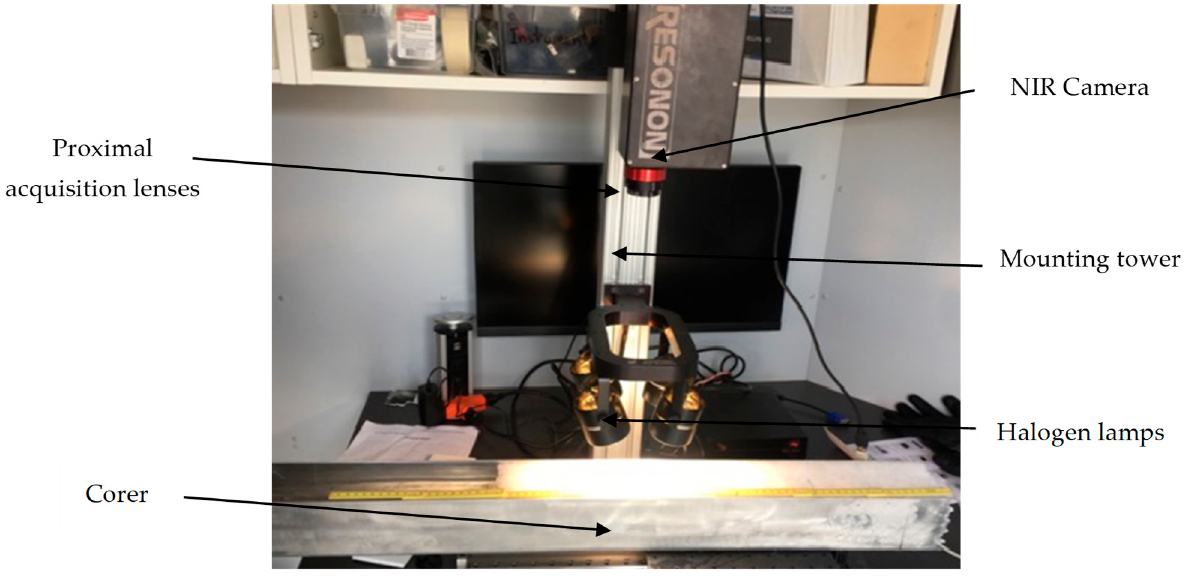
Figure 3. NIR spectral reflectance acquisition device for the vertical profile of snow samples from the company RESONON (Resonon Inc., Bozeman, MT, USA).